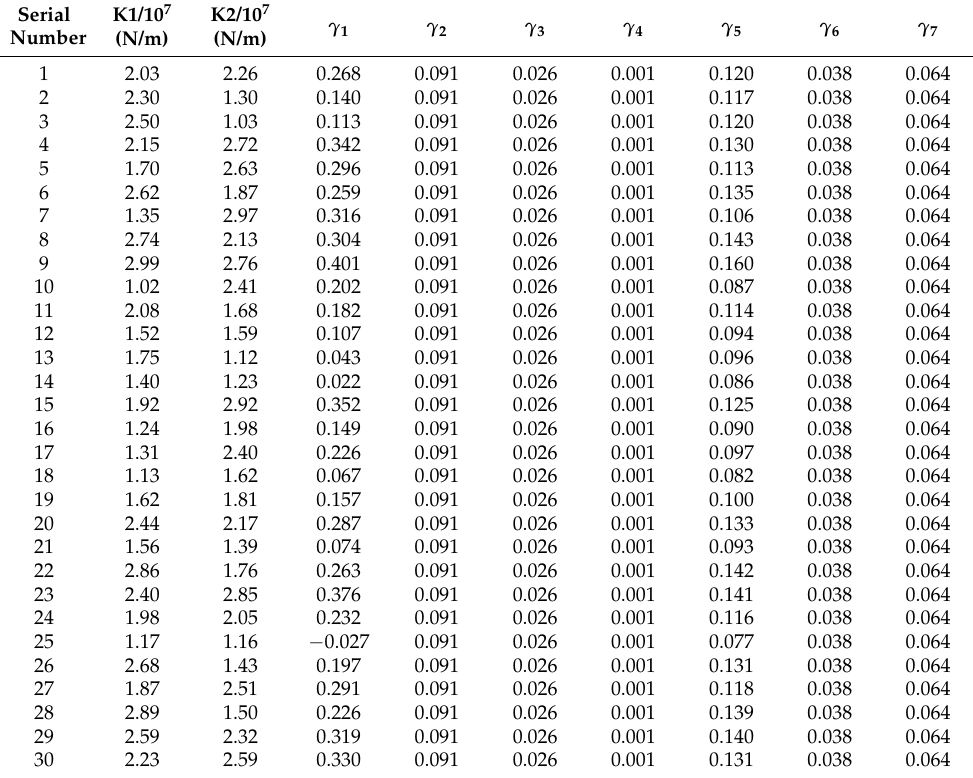
Table 3. Seven orders frequency correlation coefficients.